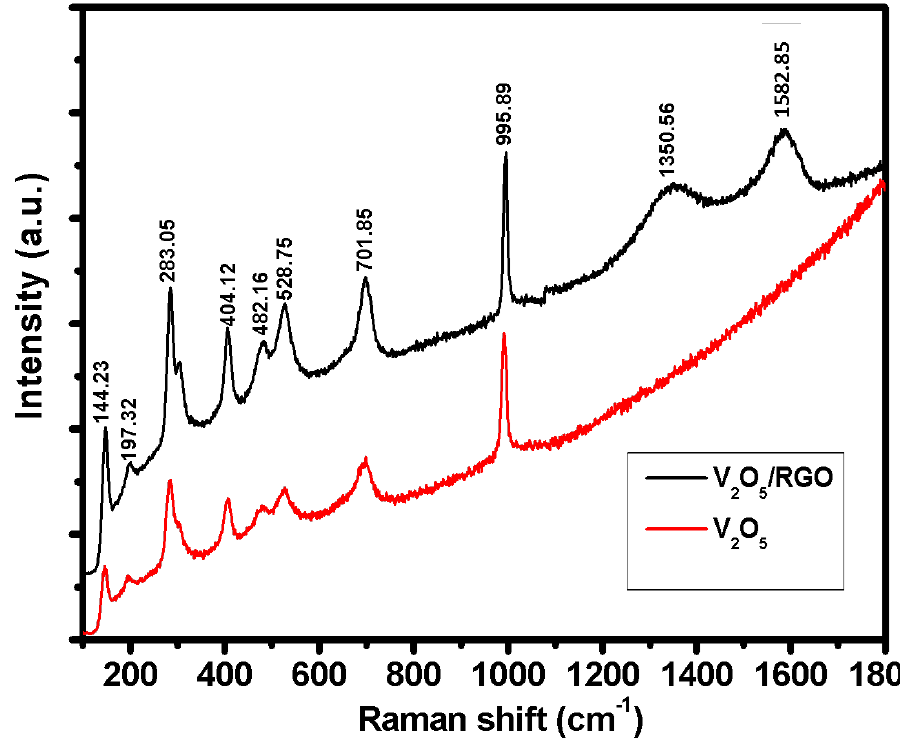
Figure 2. Raman spectra of V 2 O 5 and the V 2 O 5 /RGO composite.